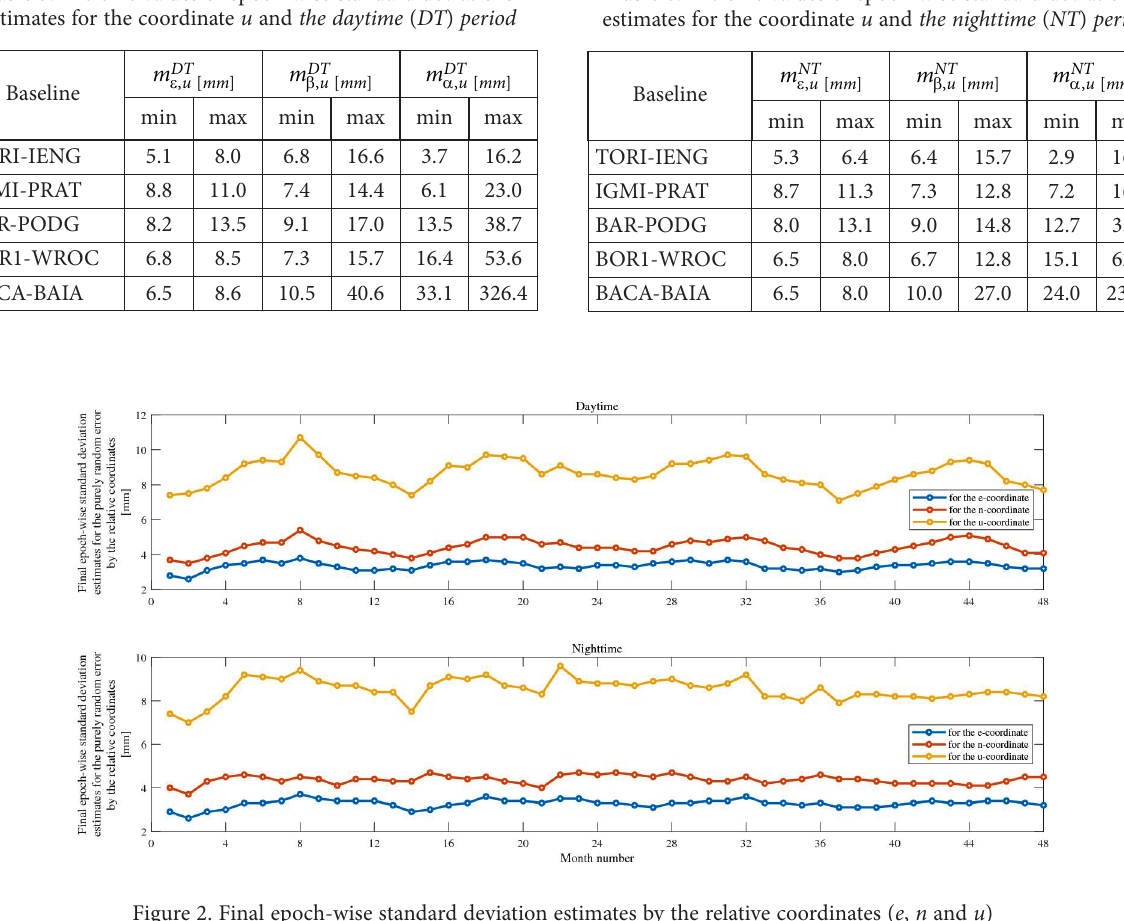
Figure 2. Final epoch-wise standard deviation estimates by the relative coordinates ( e , n and u ) for the purely random error, obtained for the daytime and the nighttime